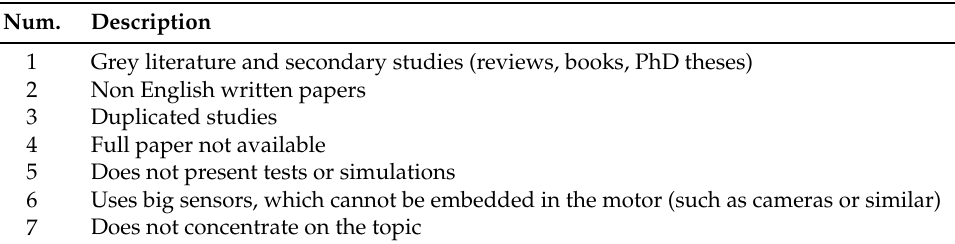
Table 2. Exclusion